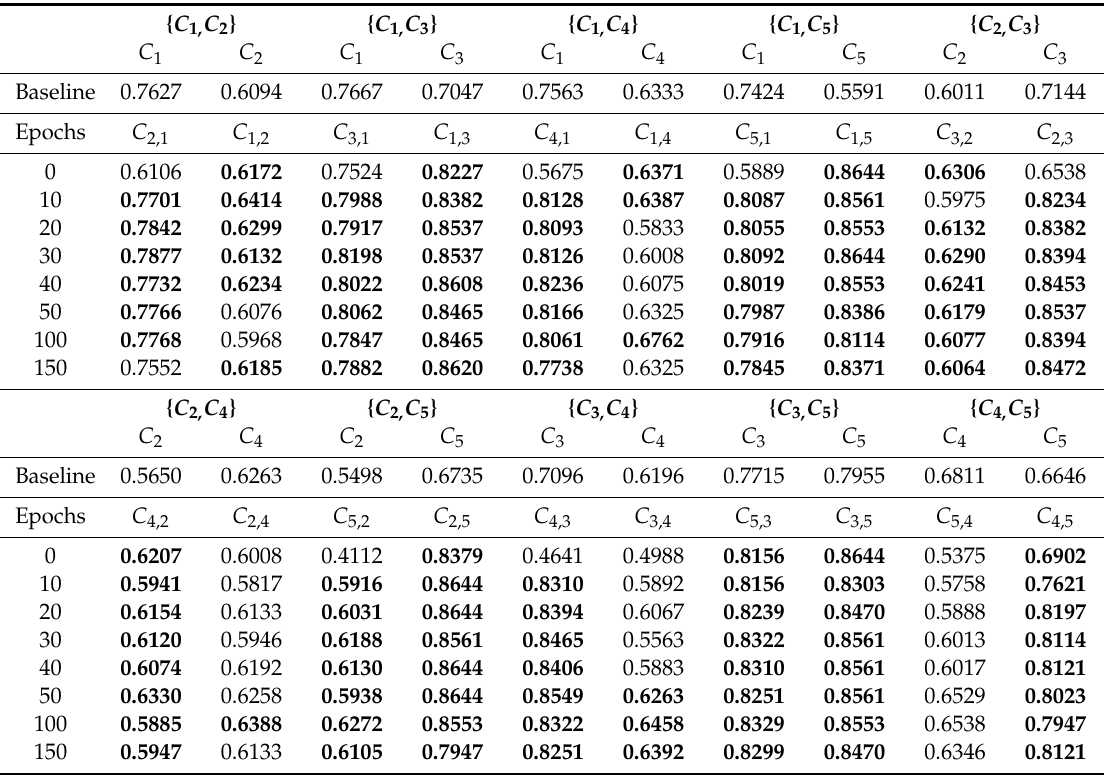
Table 4. Averaged accuracy results.